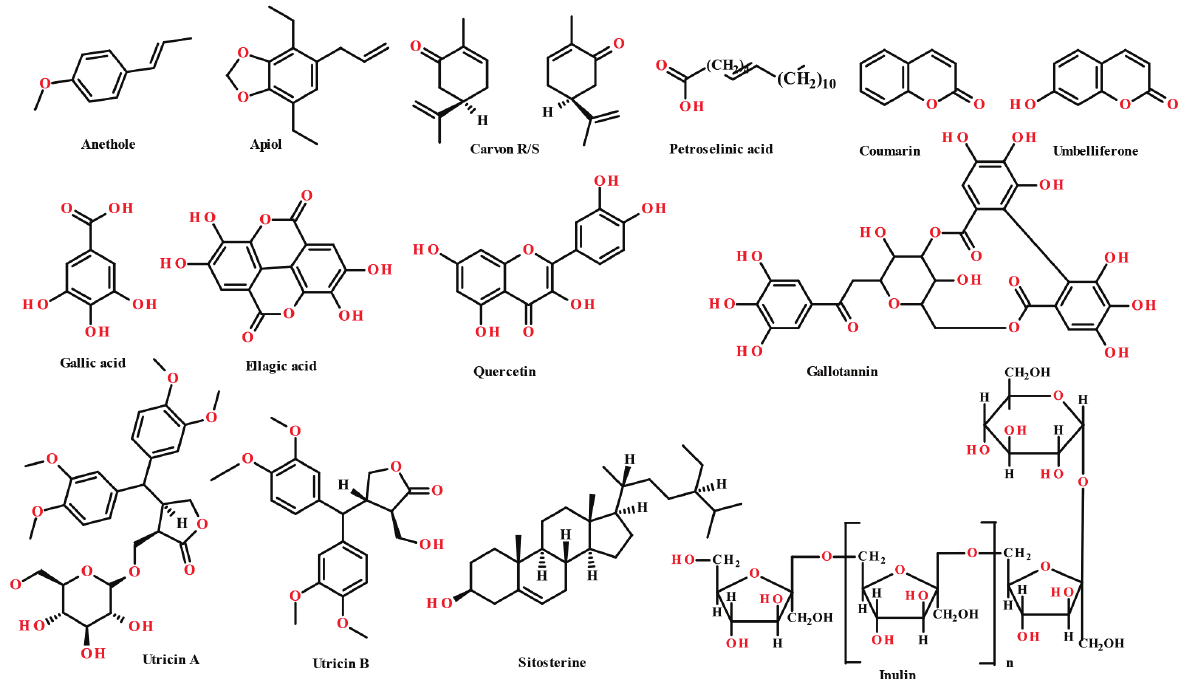
Figure 2. Biologically active compounds of the studied